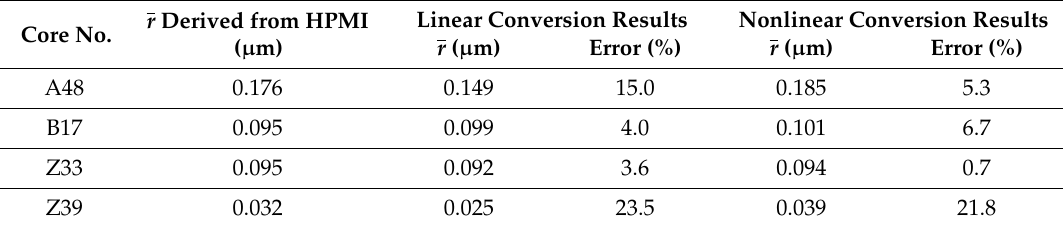
Table 5. Comparison of the calculated average pore radius from di ff erent conversion methods with the average pore radius derived from